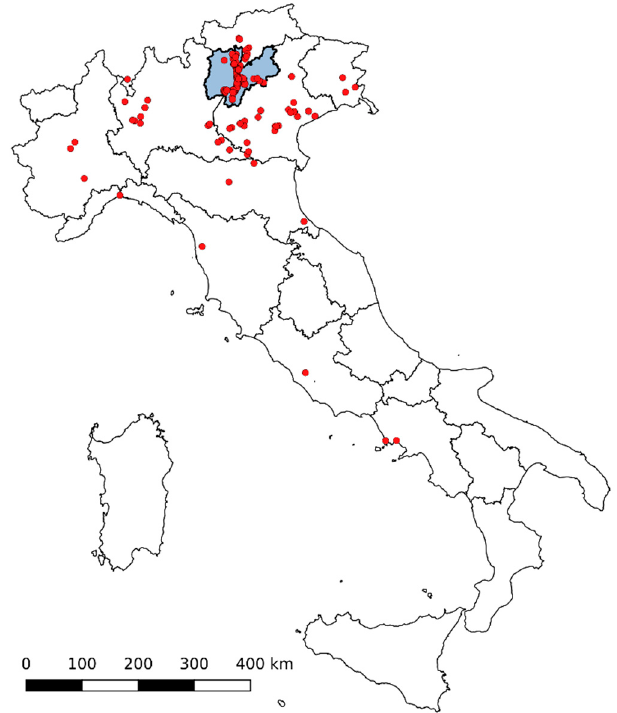
Figure 8. A map of Italy showcasing BMSB reports from the targeted Trentino (light blue) along with scattered registrations (red dots) from various Italian regions, offering an early warning for unsuspecting communities.